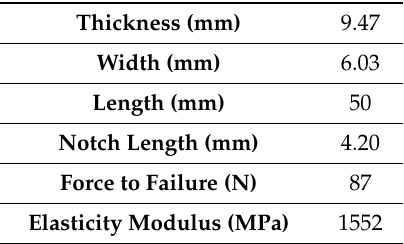
Table 5. Characteristics of LR1AL5 used in the